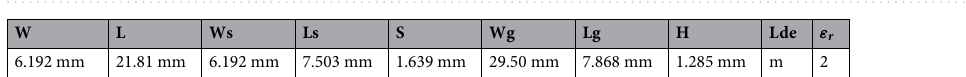
Figure 8. The details of the 3.5 GHz antenna ( a ) patch, ( b ) ground. Dimensions of the antenna in ( c ) top view, ( d ) bottom view, ( e ) side view, ( f ) gain, and ( g ) realized gain of the antenna.